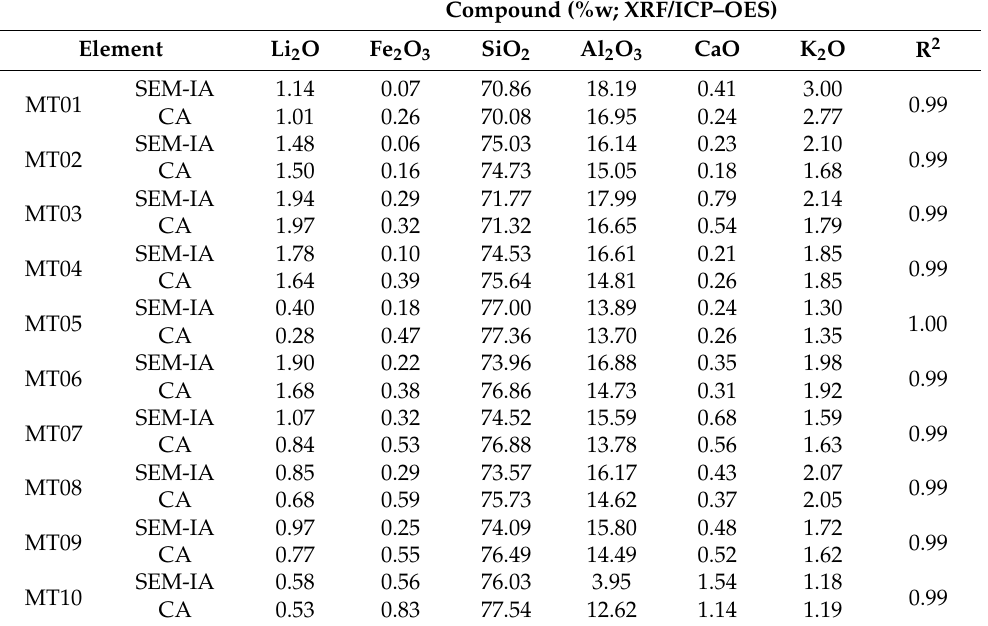
Table 3. Calculated SEM-IA vs. measured chemical analysis data for the 0.30–0.037 mm